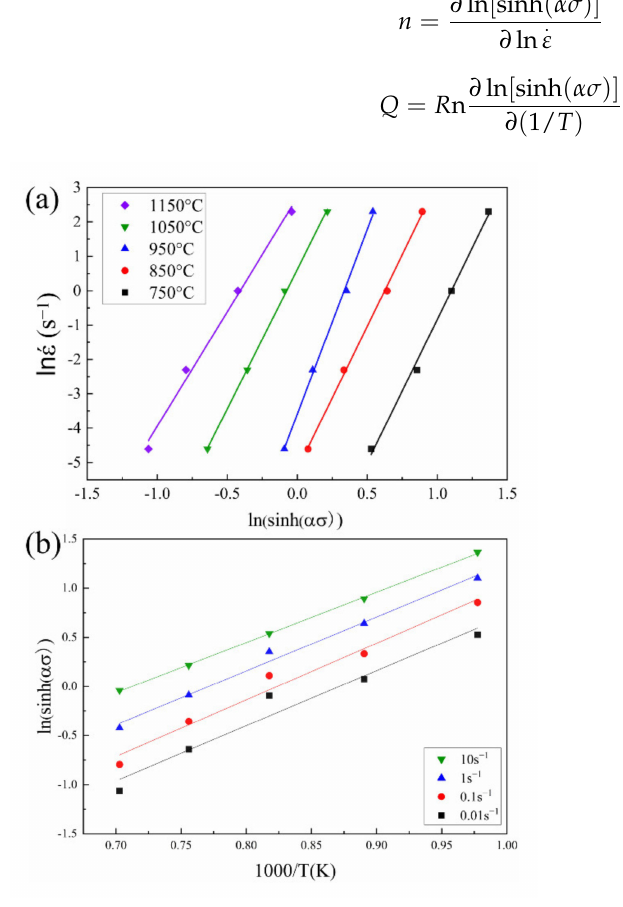
. ε − ln σ and ln(sinh( ασ ))—1000/ T as the strain is 0.3.